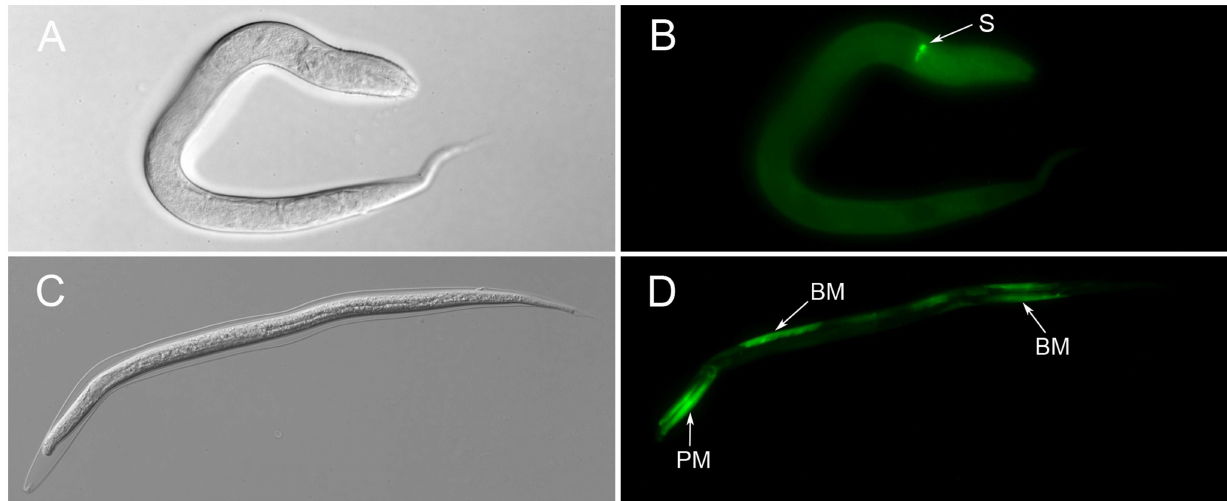
Figure 6. The anatomical expression pattern of Ss-riok-1 in the early post-free-living first stage larvae. (A, B) and in infective third-stage larvae (C, D). (A, B) strong GFP expression is found at the sphincter connecting pharynx and intestine (S). (C, D) GFP expressed in the pharynx muscle (PM) and body wall muscle (BM). Scale bars=100 m m.